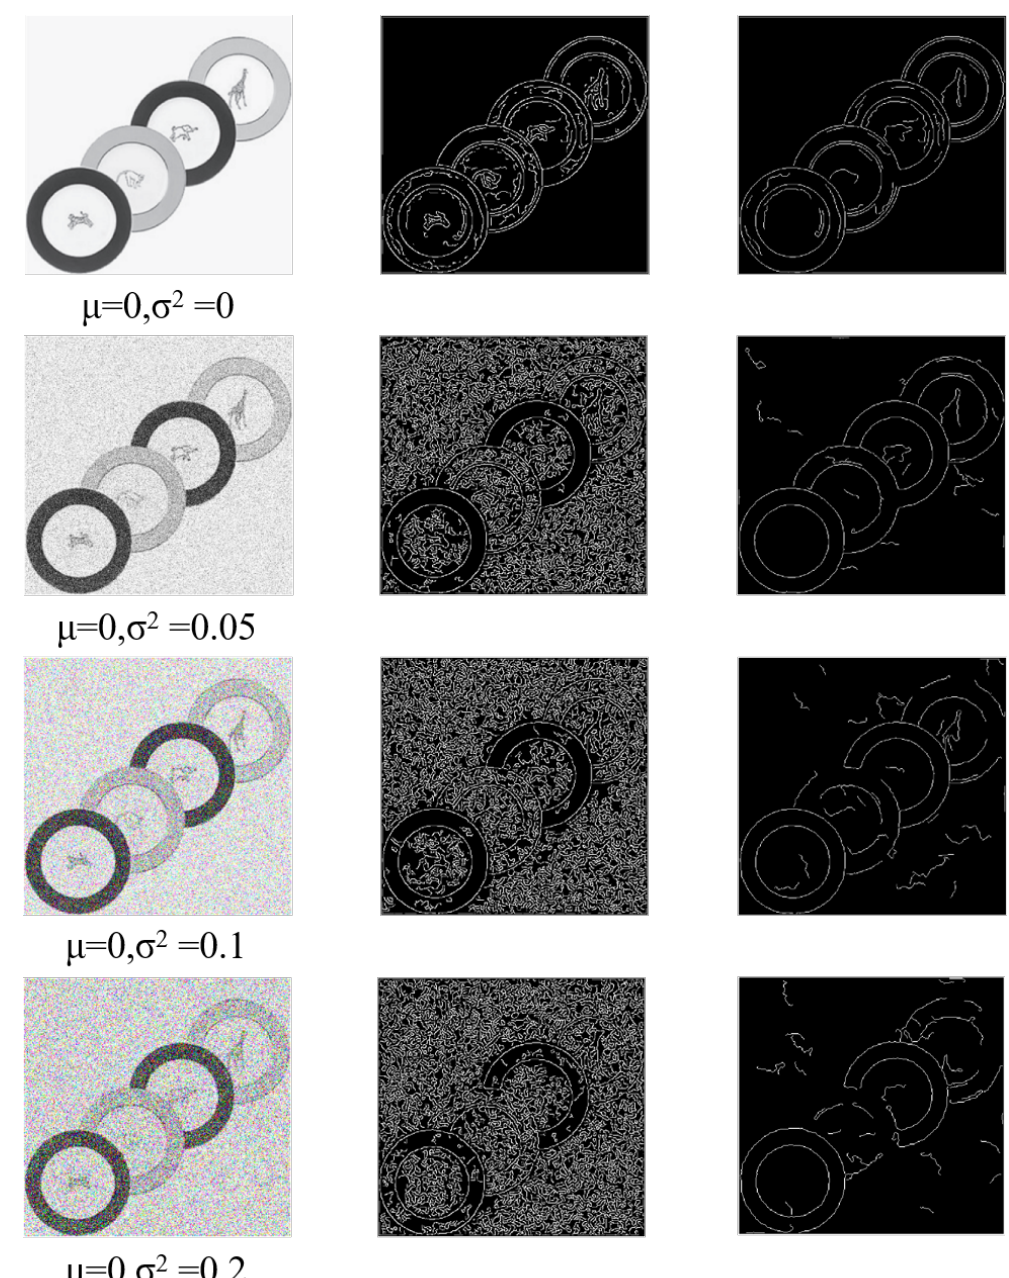
Figure 2. The results of our algorithm at different noise